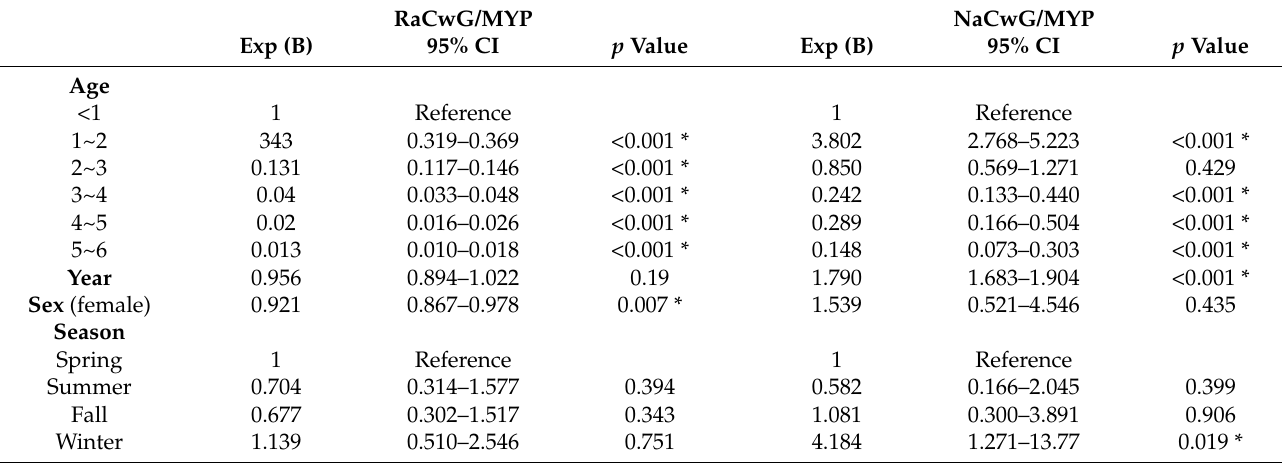
Table 2. Negative binomial regression analysis of patients with RaCwG, patients with NaCwG and the mid-year population